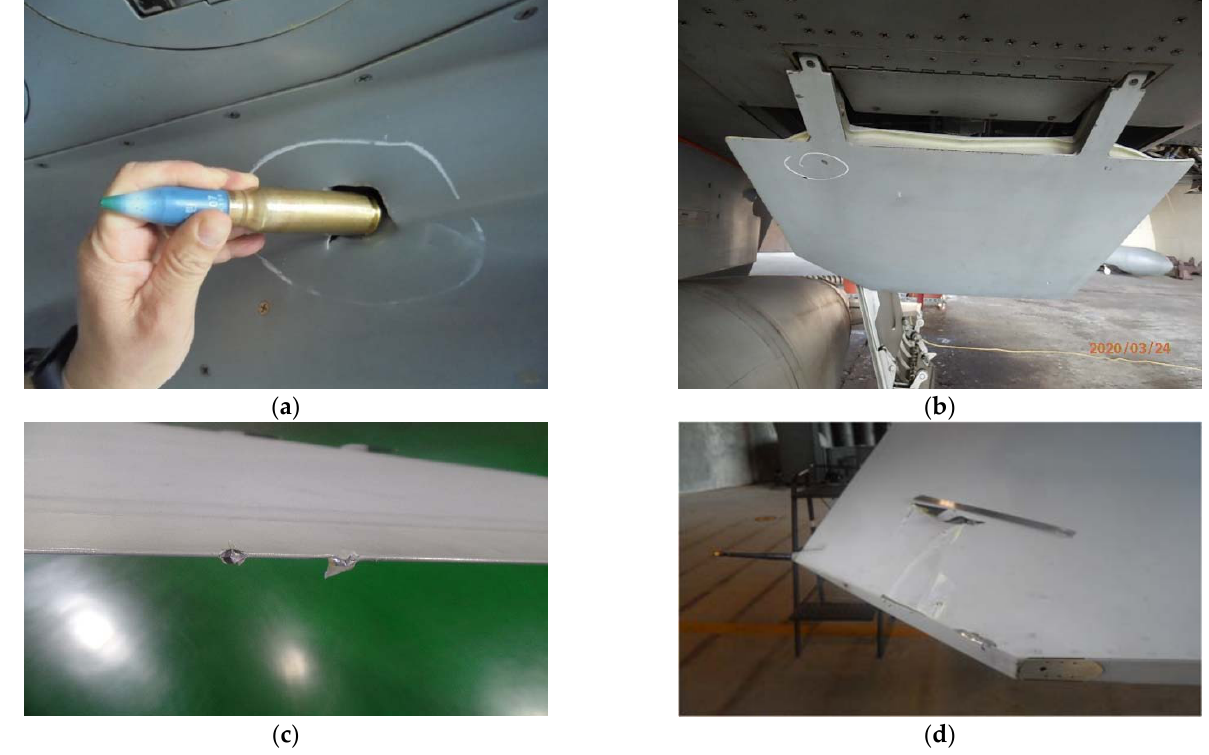
Figure 1. Damage discovered on ( a ) lower nacelle fairing cover below left air intake, ( b ) speed brake by ejected gun shell, ( c ) horizontal stabilizer damaged by metallic clips, and ( d ) fin separated from missile.